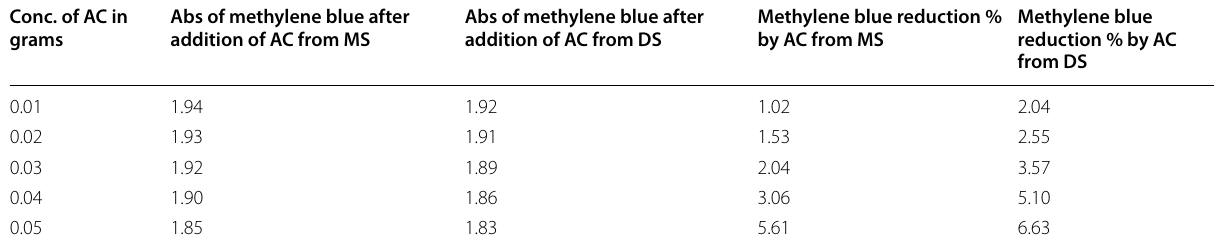
Absorbance of methylene blue